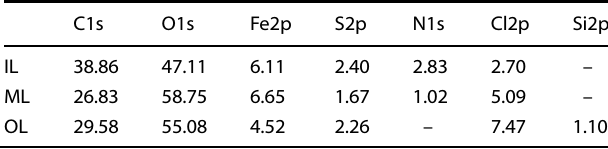
Fig. 4 XPS narrow scan spectroscopy of the corrosion products. a – d Inner layer, e – h middle layer, and i – l outer layer. Table 1. Substance content in three rust layers obtained by wide-scan XPS fi tting (at%).